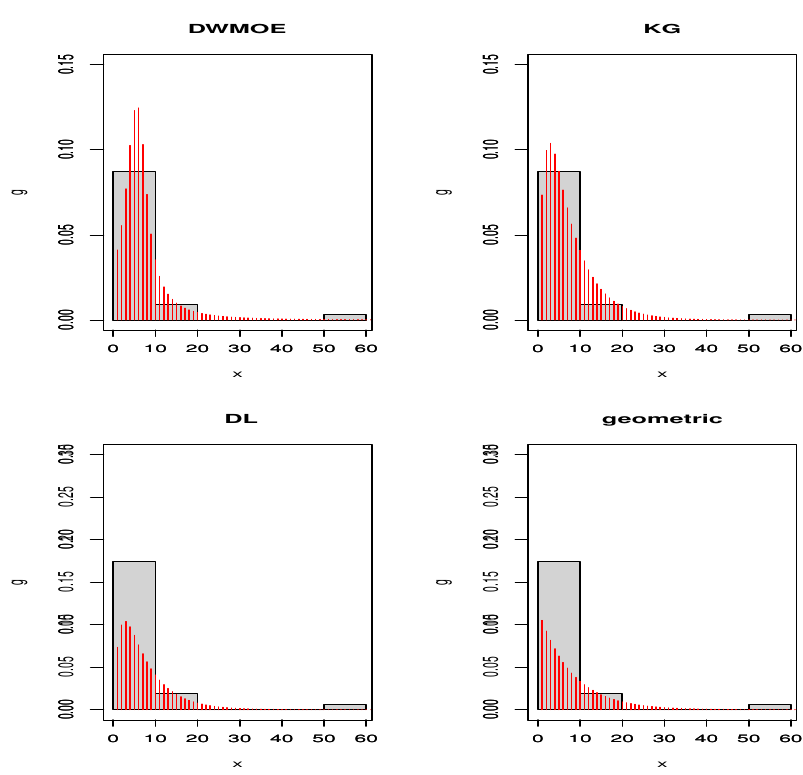
Figure 3. Plots of estimated pdfs of distributions for Data set 1.